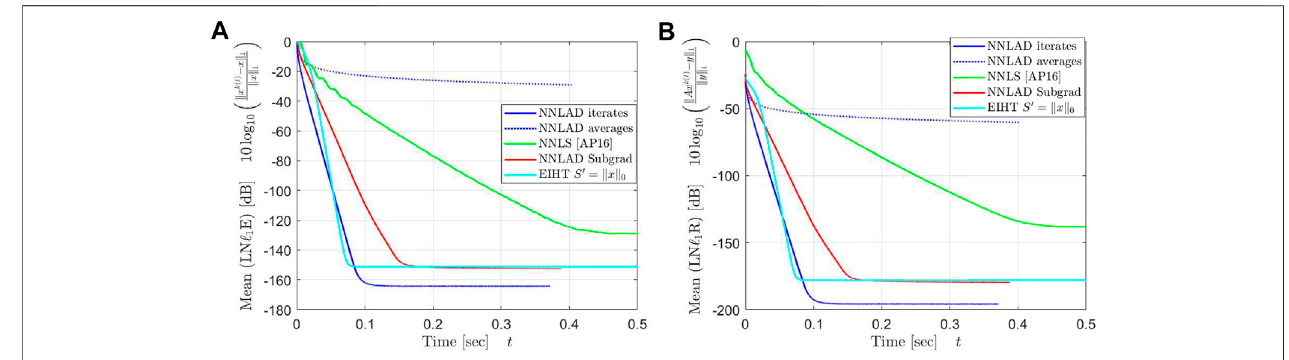
FIGURE 9 | Convergence rates of certain iterated methods with respect to the time. A is Bernoulli for NNLS and D-LRBG for the others.